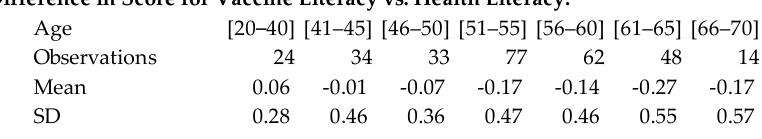
Figure 1. Difference in score for vaccine literacy versus health literacy with age of family